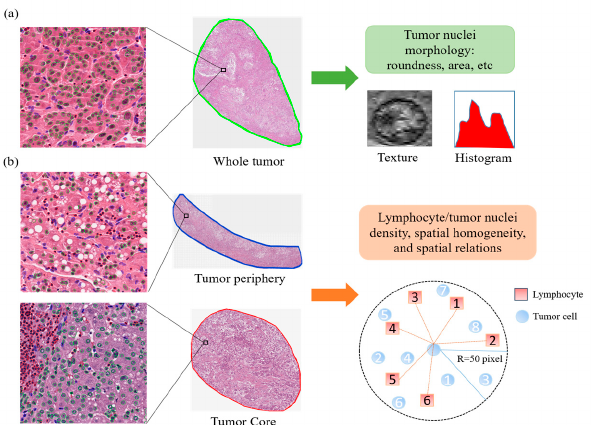
Figure 2. Feature extraction of pathological images. ( a ) For the whole tumor area, morphology,